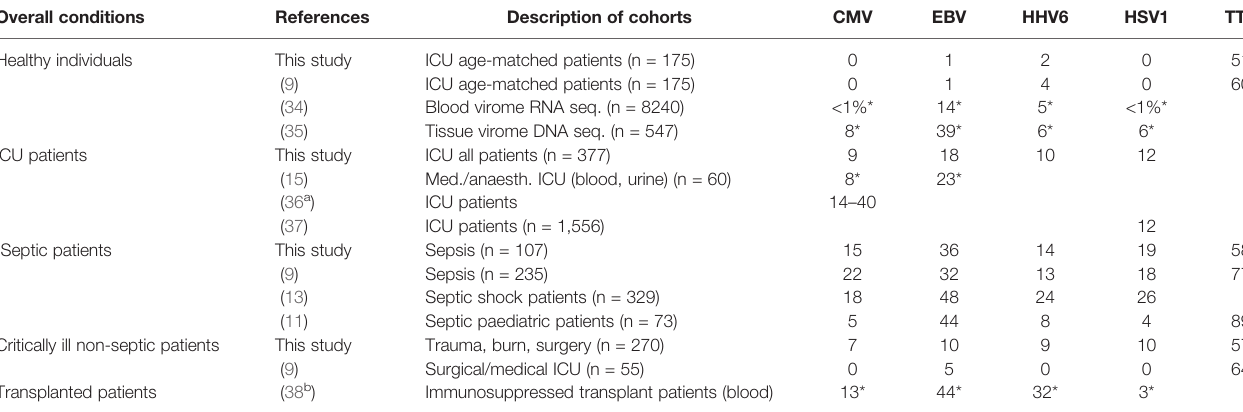
TABLE 5 | Cumulative percentages of reactivation of various herpesviruses and TTV in healthy individuals, critically ill patients during ICU stay, and immunosuppressed transplant